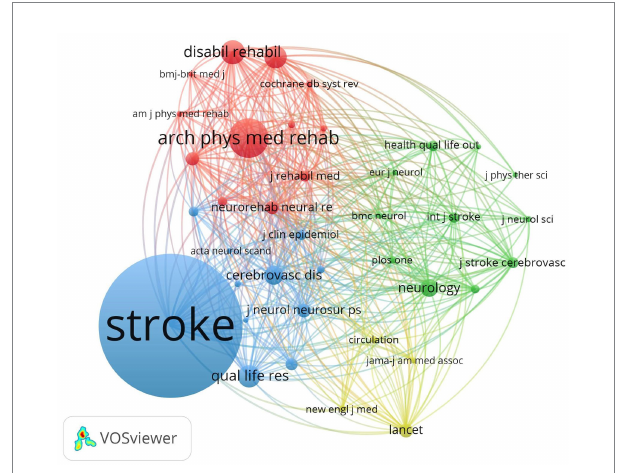
FIGURE 1 Map of co-cited journals with